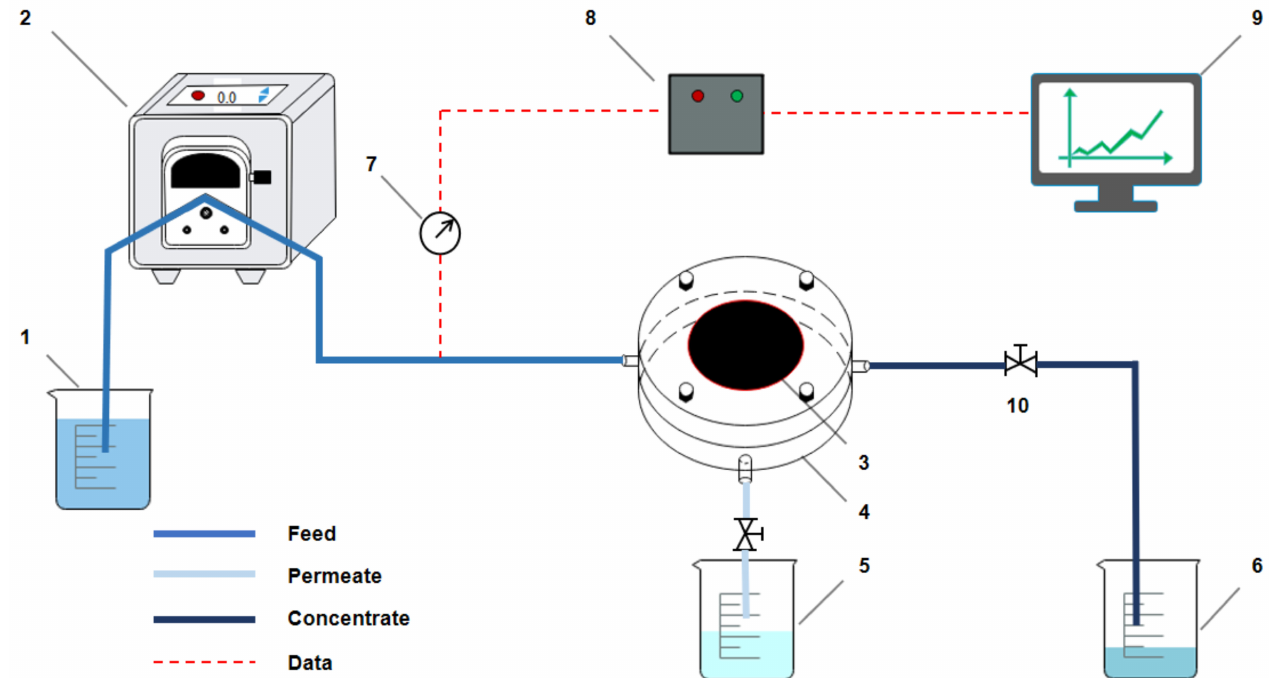
Figure 2. Schematic of the membrane filtration test. 1. Liquid inlet storage tank; 2. peristaltic pump; 3. membrane module; 4. ultrafiltration membrane; 5. liquid outlet storage tank; 6. cross flow liquid storage tank; 7. pressure senor; 8. PLC (programmable logic controller); 9. computer; 10.